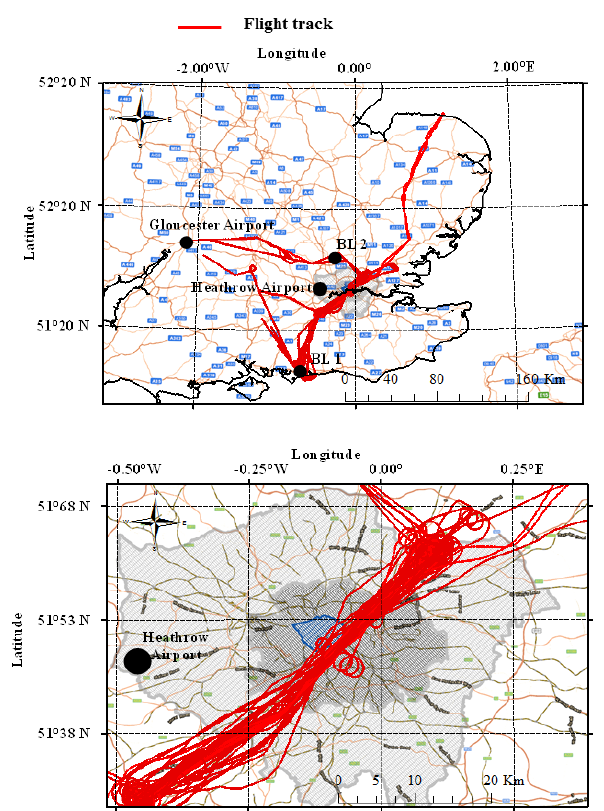
Figure 1. Top map shows all NERC Dornier 228 flights overlaid on UK transport map. Bottom map shows total flight legs across Greater London. Grey area: Greater London boundary; black area: inner London boundary; blue area: London